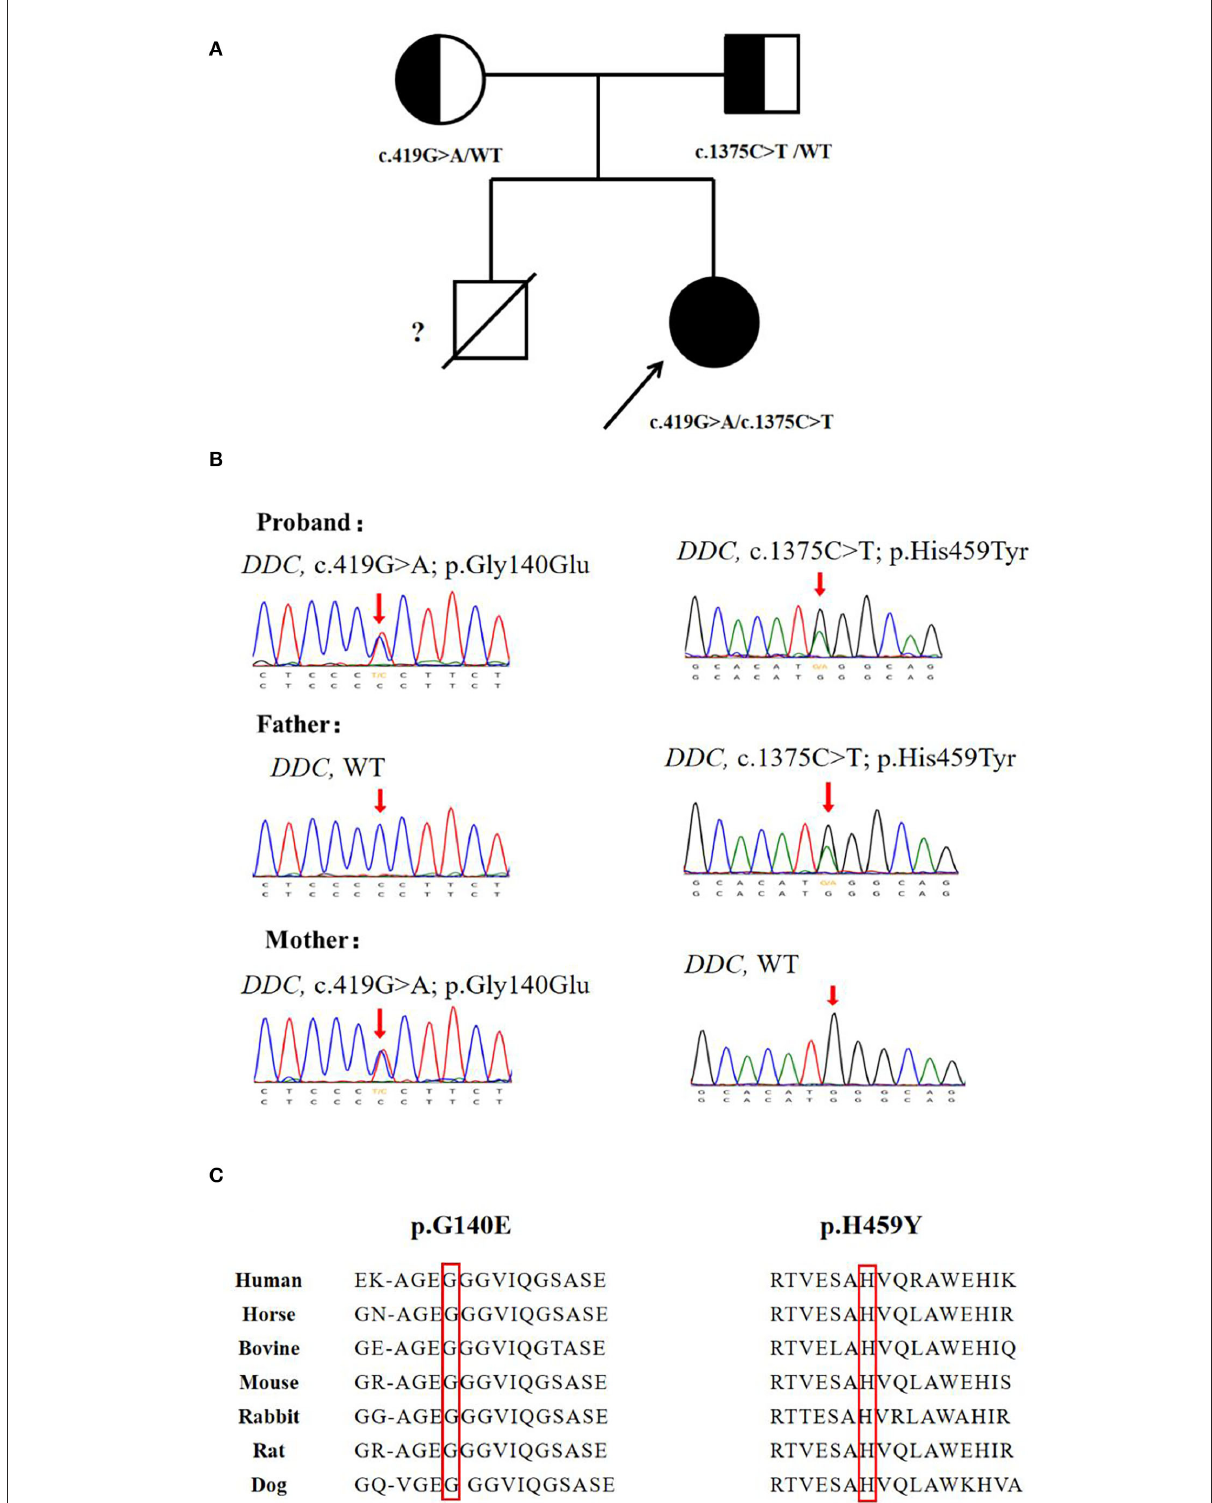
FIGURE1 Genetic analysis of the DDC gene. (A) Pedigree for the proband’s family. (B) Sanger sequencing analysis for DDC mutation identified in the family. (C) The missense variants sp.G140E and p.H459Y are highly conserved among